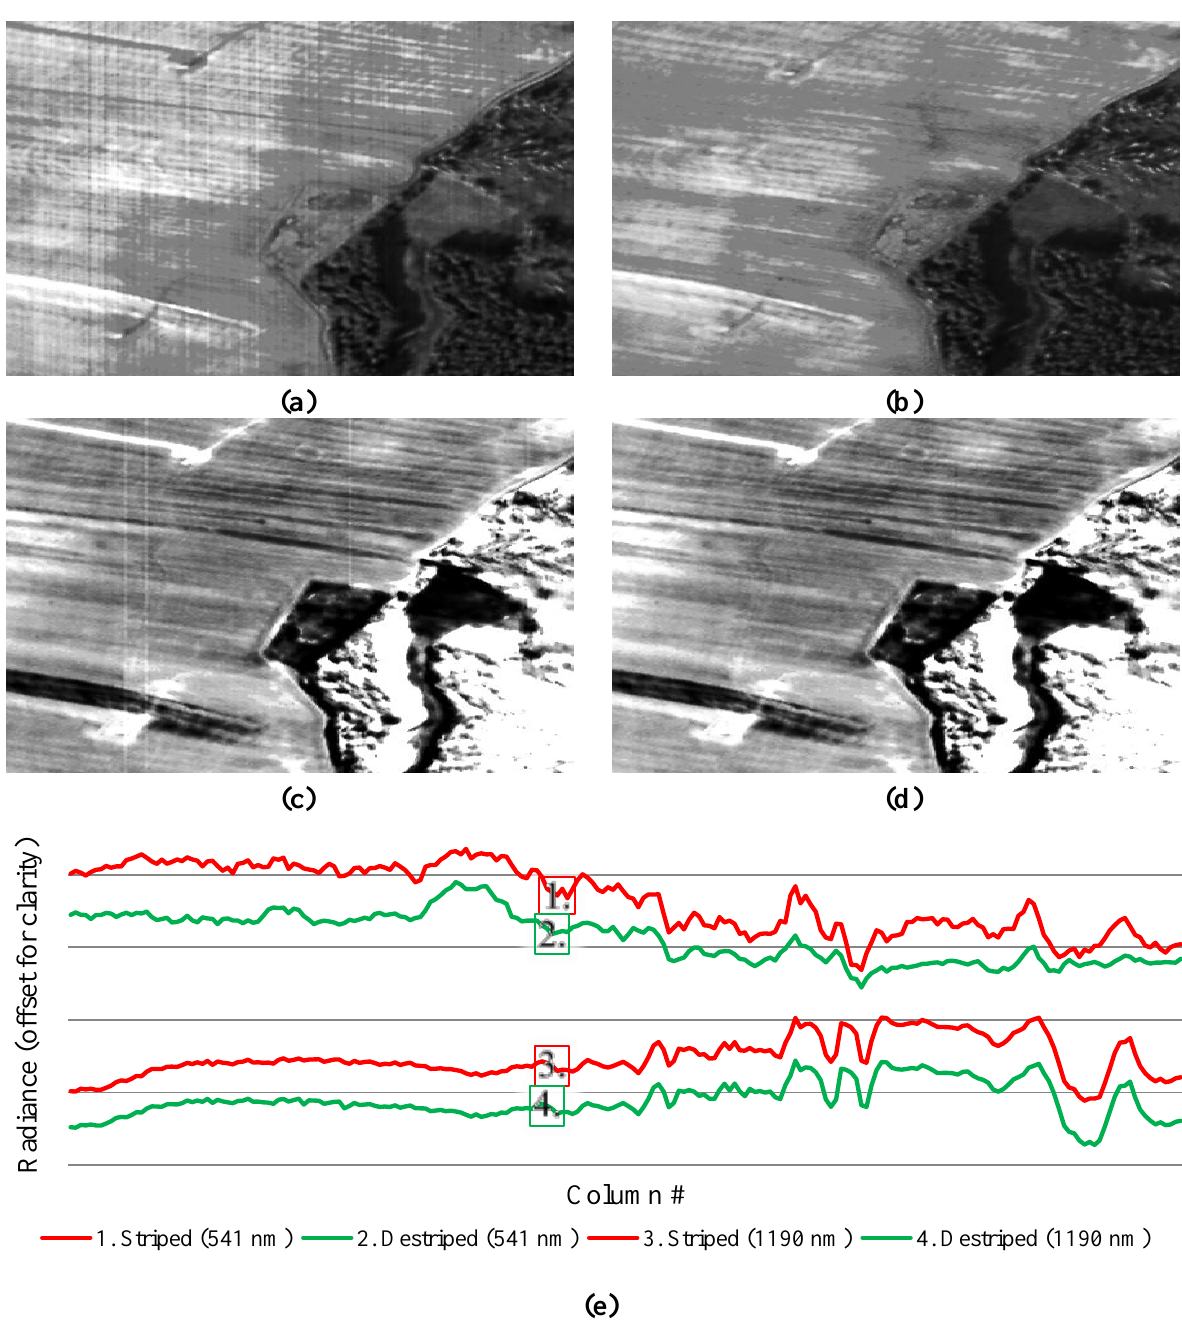
Figure 6. Exemplary grey scaled, striped images of sections in the middle of an AISA DUAL scene (VNIR-band 65–541 nm (a) , SWIR-band 283–1190 nm (c) and their respective radiometrically recalibrated results (VNIR (b) , SWIR (d) as well as a transect plot (e) through the middle of the same section for same VNIR and SWIR